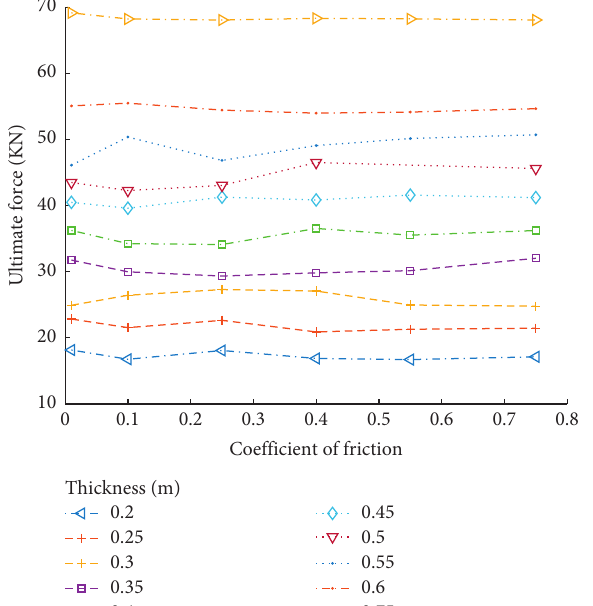
Figure 17: Ultimate force vs coefficient of friction for varying thicknesses.